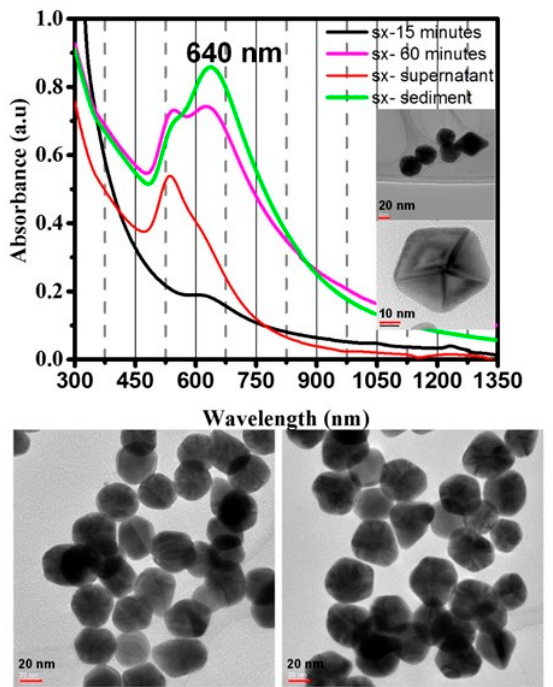
Figure 5. Characterization of NIRAuNM formed within 0.5% wt/v of PNIPAm-co-allylamine microgels by photolysis of 0.016 mmol of Au(Me 2 S)Cl in aqueous microgels media by a single-step method. Time-dependent absorption spectra and TEM images are included.